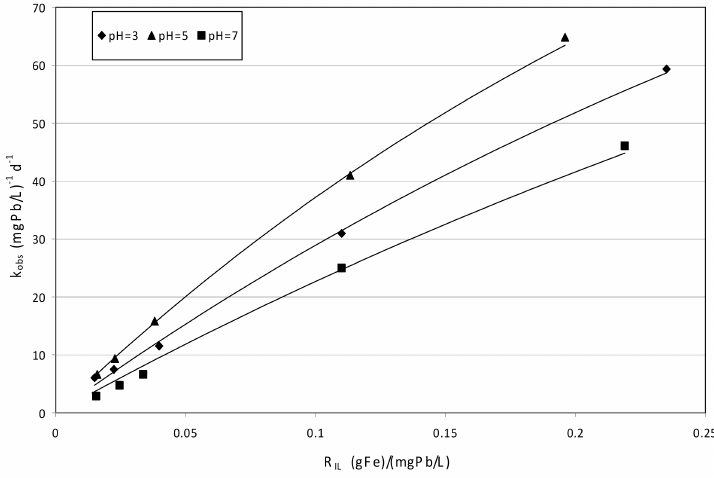
Figure 18. Observed kinetic constant (k obs ), detected during the tests with MgO_nZVI, vs. Fe/C i